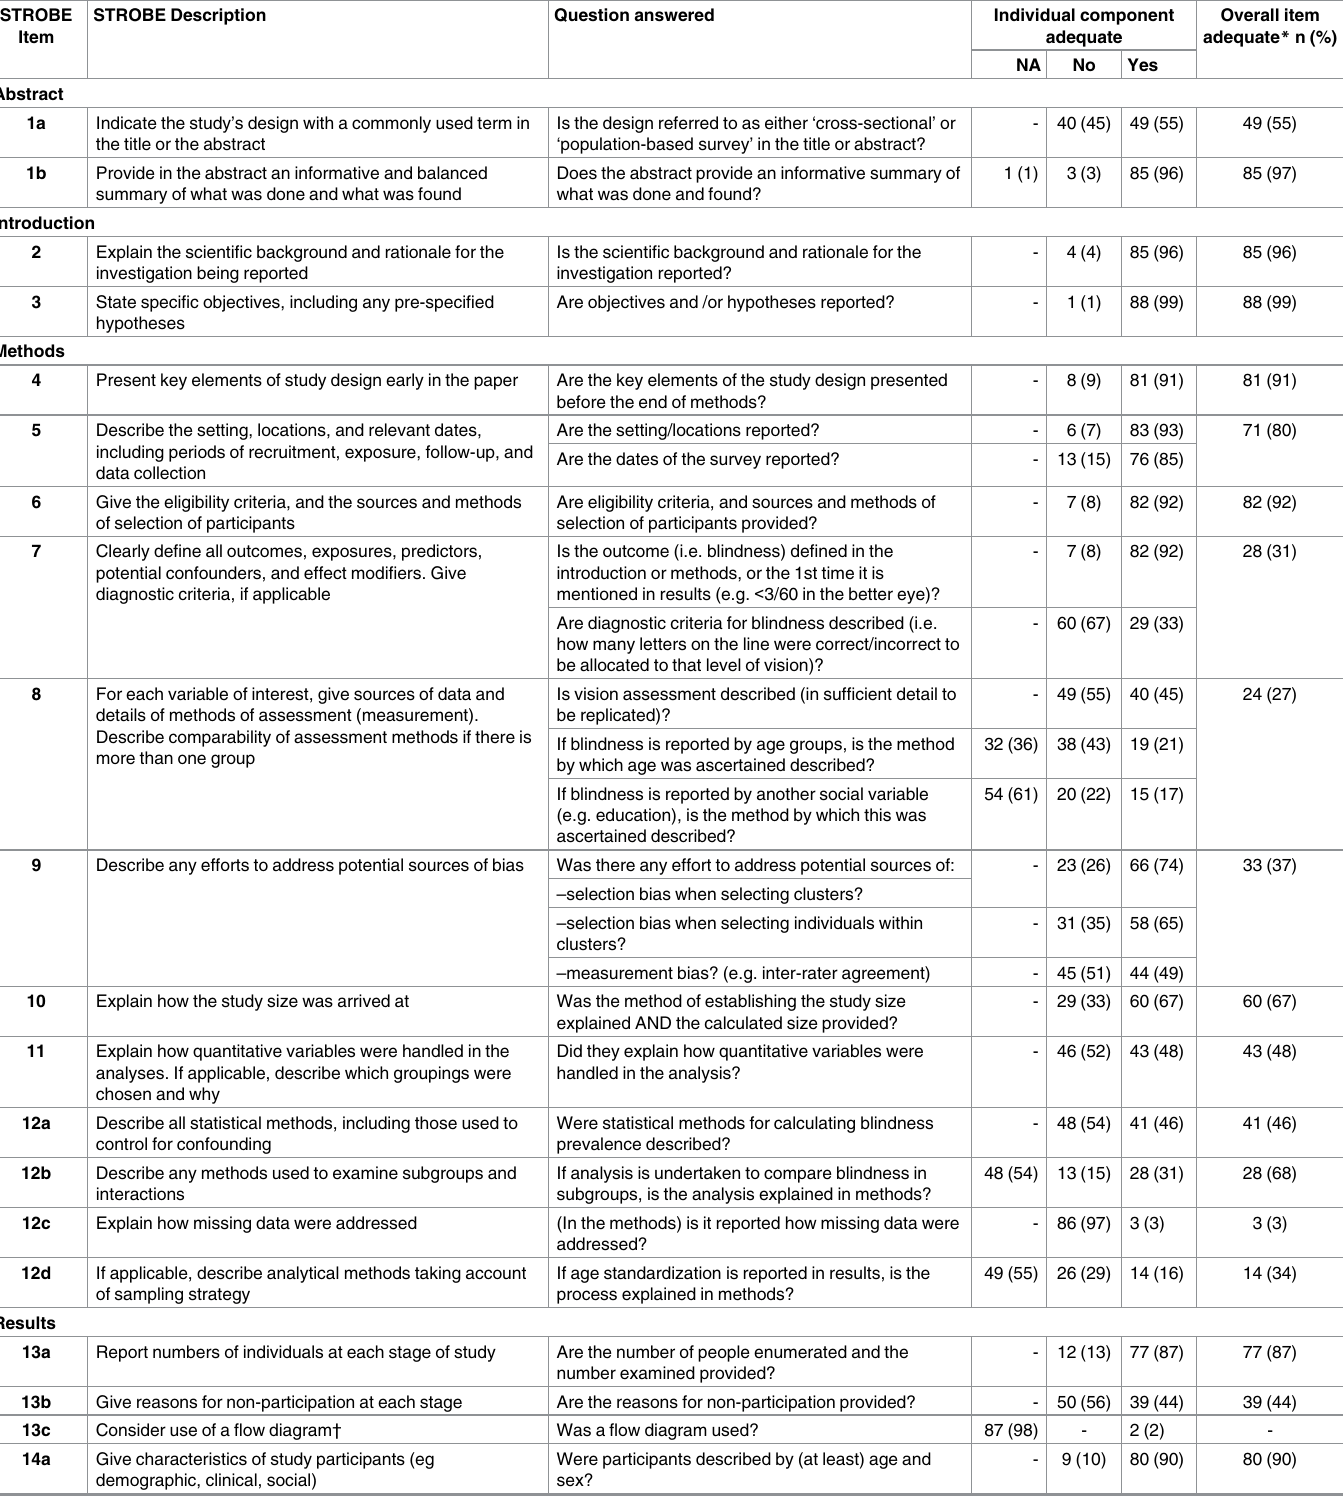
Table 2. Reporting of STROBE items in 89 blindness prevalencesurveyspublished between January 2008 and March 31 2016. STROBE